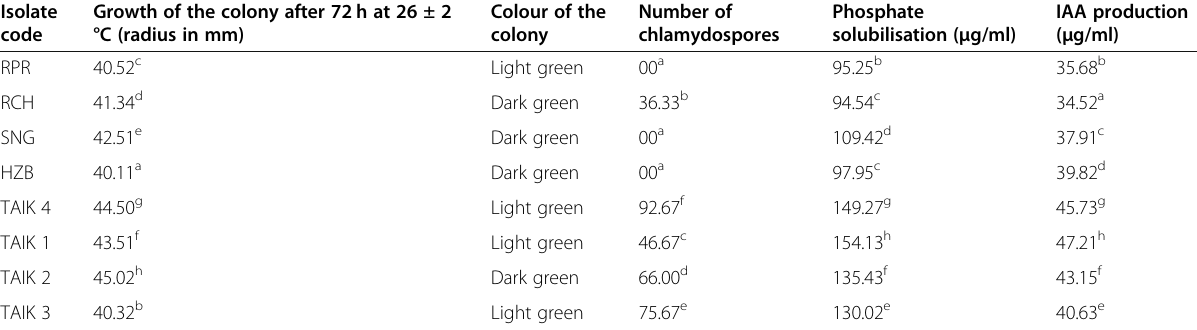
Data depicts the mean of three replications. Numerical values with different letters are significantly different ( P ˂ 0.05, Duncan ’ s multiple range test, SPSS). Different locations: RPR Raipur, RCH Raichur, SNG Sanga Reddy, HZB